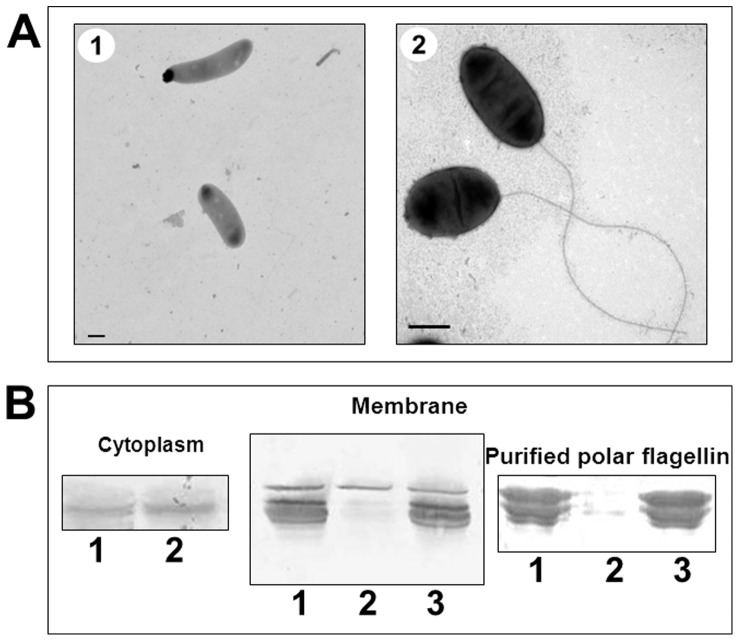
A/Electron microscopy of whole cells from A. hydrophila AH-3:WecX mutant (1) and the mutant complemented with pBAD-WecX (2) stained according to Experimental Procedures.Bar represents 1μ. B/Western blots using specific antiserum against purified polar flagellins. Molecular weights are indicated. Cytoplasmic fractions (C), Whole membrane fractions (M), and partially purified polar flagellins (F), the fractions were separated as indicated in Materials and Methods section. Strains: 1, A. hydrophila AH-3 (wild type); 2, AH-3:WecX mutant, and 3 the mutant complemented with pBAD33-WecX.